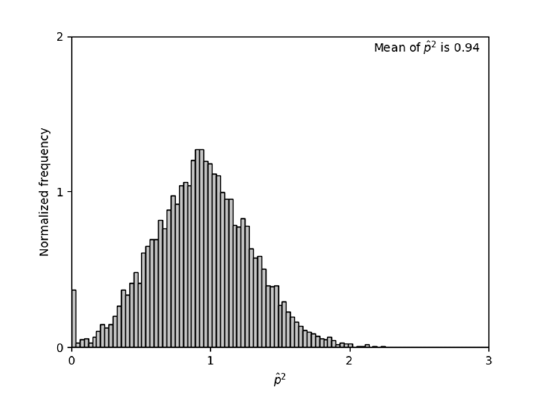
Fig. 8. Histogram of 𝑝 2 (cid:3554) (when 𝐕(cid:3553) 𝐦 (cid:3404) 𝑝 (cid:2870) (cid:3554)𝐕 𝐦 )